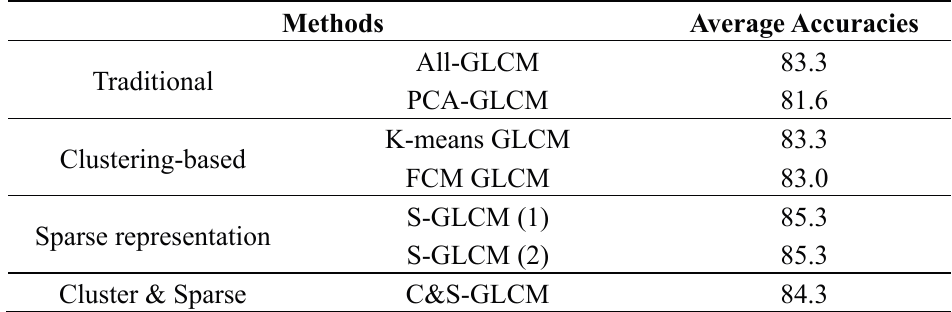
Table 4. The average accuracies (OA%) of each GLCM method over the 14 window sizes and four quantization levels for the GeoEye-1 Wuhan